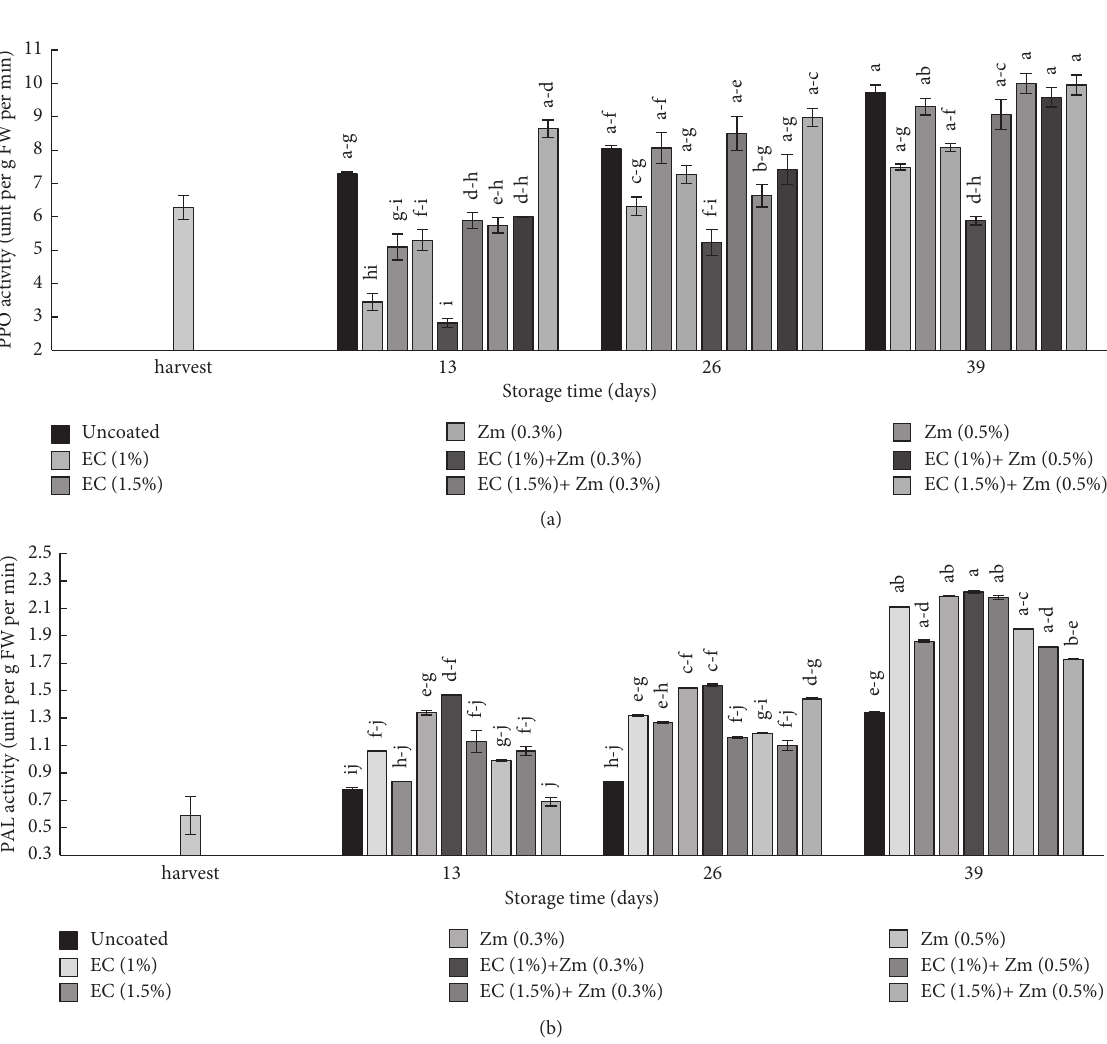
Figure 2: PPO (a) and PAL activity (b) of the fresh pistachio hull coated with sodium alginate+ Zataria multiflora at 3 ± 1 ° C. Means ( n � 3) with the same letters are not significantly different according to Duncan’s test ( p > 0 . 05 ) . EC: alginate-based edible coating; Zm: Zataria multiflora